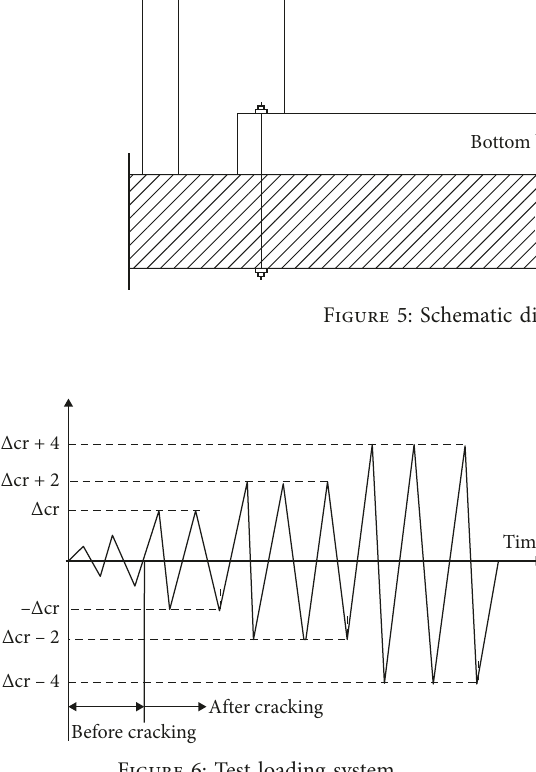
Figure 6: Test loading system.